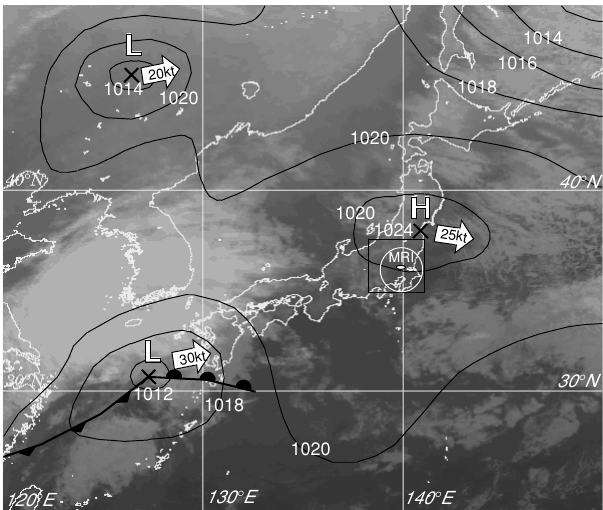
Fig. 3. Surface isobars superimposed over GMS-5 visible imagery from 15:00 JST on 29 December 1997. A square indicates the ana- lytical area in Fig. 5. A white circle surrounds the Kanto Plain, and an oval in the circle indicates the location of the